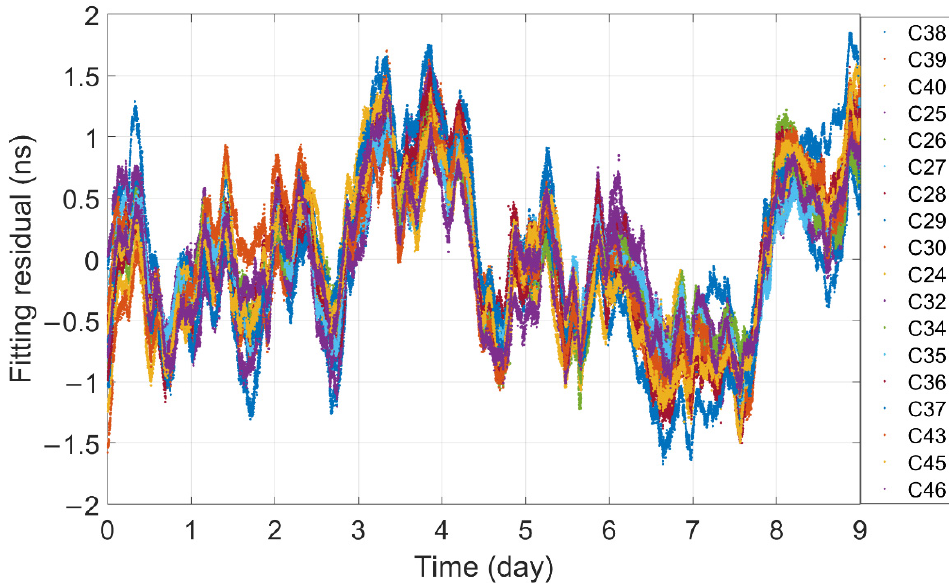
Figure 13. Multi-day fitting residuals of BDS-3 satellite with highest-level-performance atomic clock onboard with respect to BDT (since 19 May 2022). The common fluctuation is caused by the fluctuation in BDT output signals.